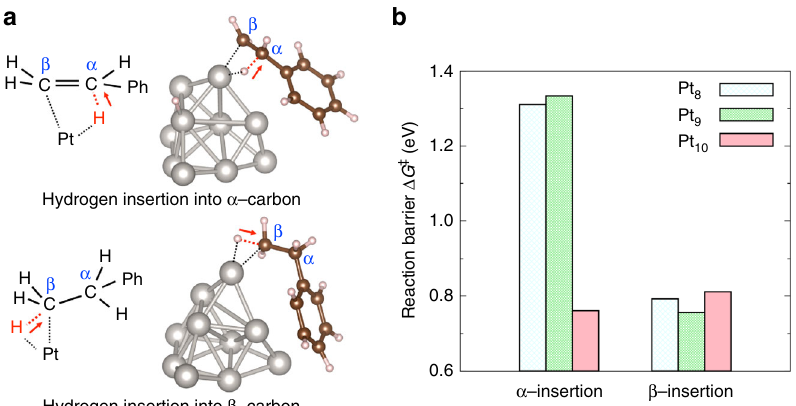
Fig. 4 Styrene hydrogenation and its reaction barriers under the existence of platinum catalysts. a Hydrogen insertion processes into α -carbon and β -carbon, and the corresponding transition states with Pt 10 catalyst. b Calculated reaction barriers under the existence of Pt 8 , Pt 9 , or Pt 10 catalyst. Density functional theory calculations were performed at the B3LYP/LanL2DZ and 6 – 31 G (d, p) level